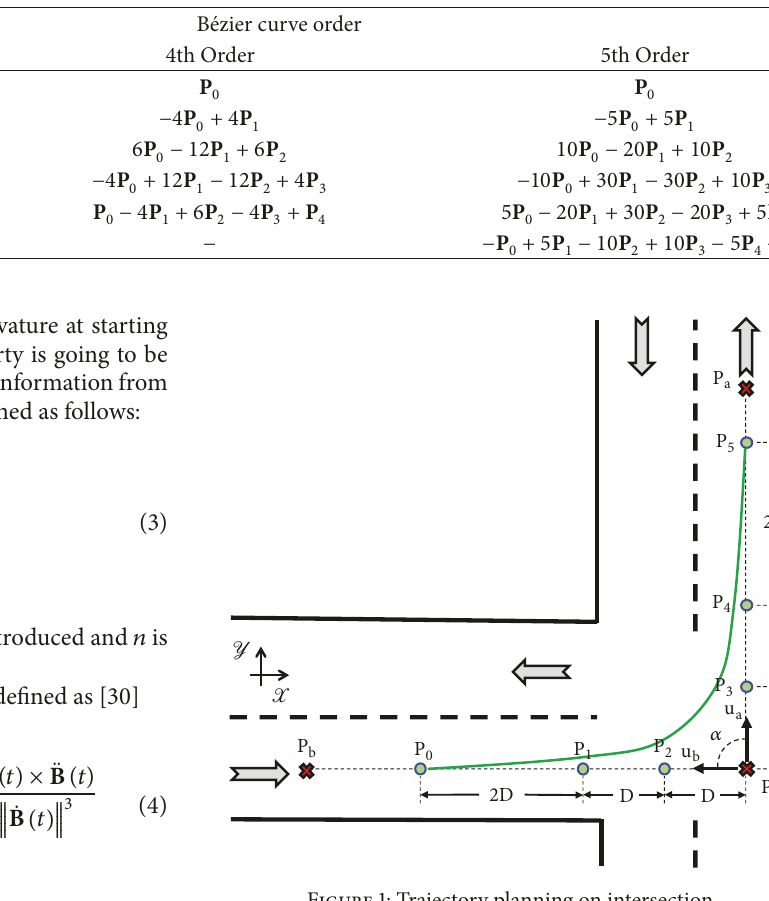
Table 1: Compact B´ezier polynomial Coefficients “C”.